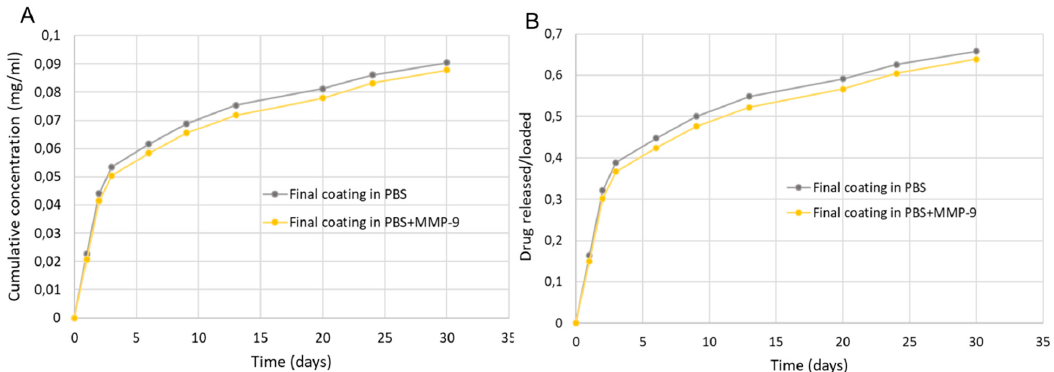
Figure 8. ( A ) Cumulative concentration of Dexa released from composite coating in PBS and in PBS with the addition of MMP-9; ( B ) amount of Dexa released with respect to the initial content of Dexa loaded into both PVA hydrogel and PHBHV fiber mesh.